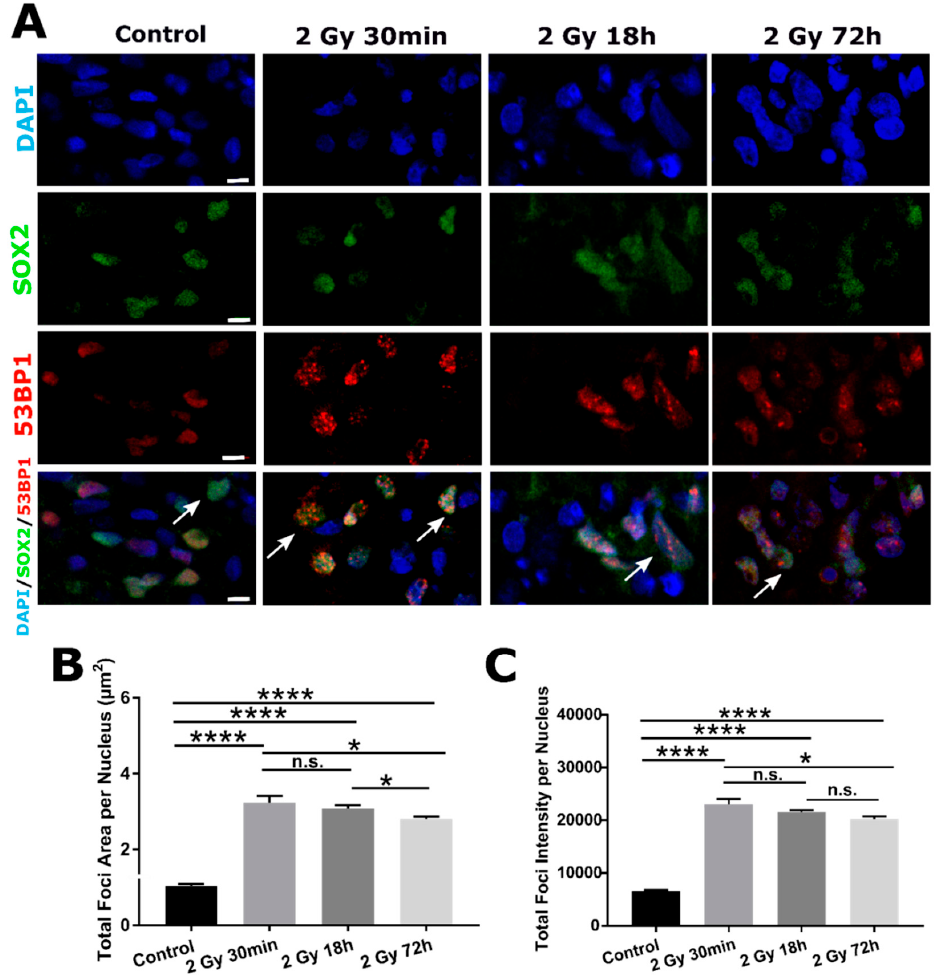
Figure 5. DSB DNA -damage response of SOX2 + cells assessed by 53BP1 DSB marker. ( A ) Representative images of DAPI (first row, blue), SOX2 antibody (second row, green) and 53BP1 antibody (third row, red) organoid staining. On merged images (fourth row), few SOX2 + /53BP1 + cells are indicated with white arrows. Radiation-induced damage to SOX2 + cells is assessed by total 53BP1 + foci area ( B ) and intensity ( C ) per nucleus (data are represented as bar charts showing foci signal mean values. N = 3 organoids per group, n = 30 ROIs per group, total amount of DAPI + cells analyzed per group n > 2000). Scale bars 5 µm ( A ). n.s.—non-significant, * p < 0.05, **** p < 0.0001 (one-way